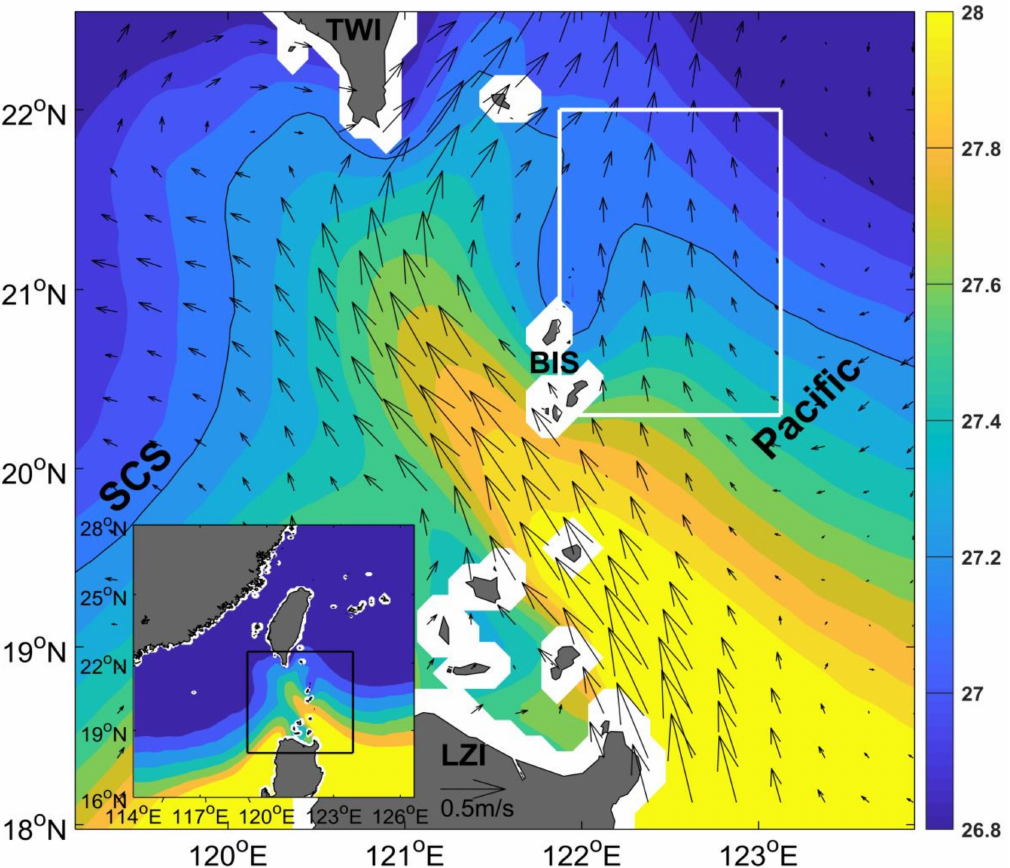
Figure 1. Climatology of geostrophic current and sea surface temperature (SST) around the LS. The black line represents 27.2 ◦ C, in order to emphasize the spatial patterns of two warm tongues. The white box covers 20.3 ◦ N–22 ◦ N, 121.875 ◦ E–123.125 ◦ E. Geostrophic current (m/s, in vector); SST ( ◦ C, in color); TWI: Taiwan Island; BIS: Batanes Islands; LZI: Luzon Island; SCS: South China Sea. The extent of the main map is shown as a black box in the